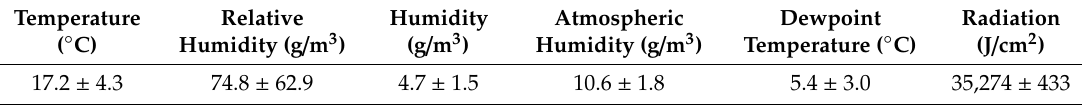
Table 2. Environmental conditions in the